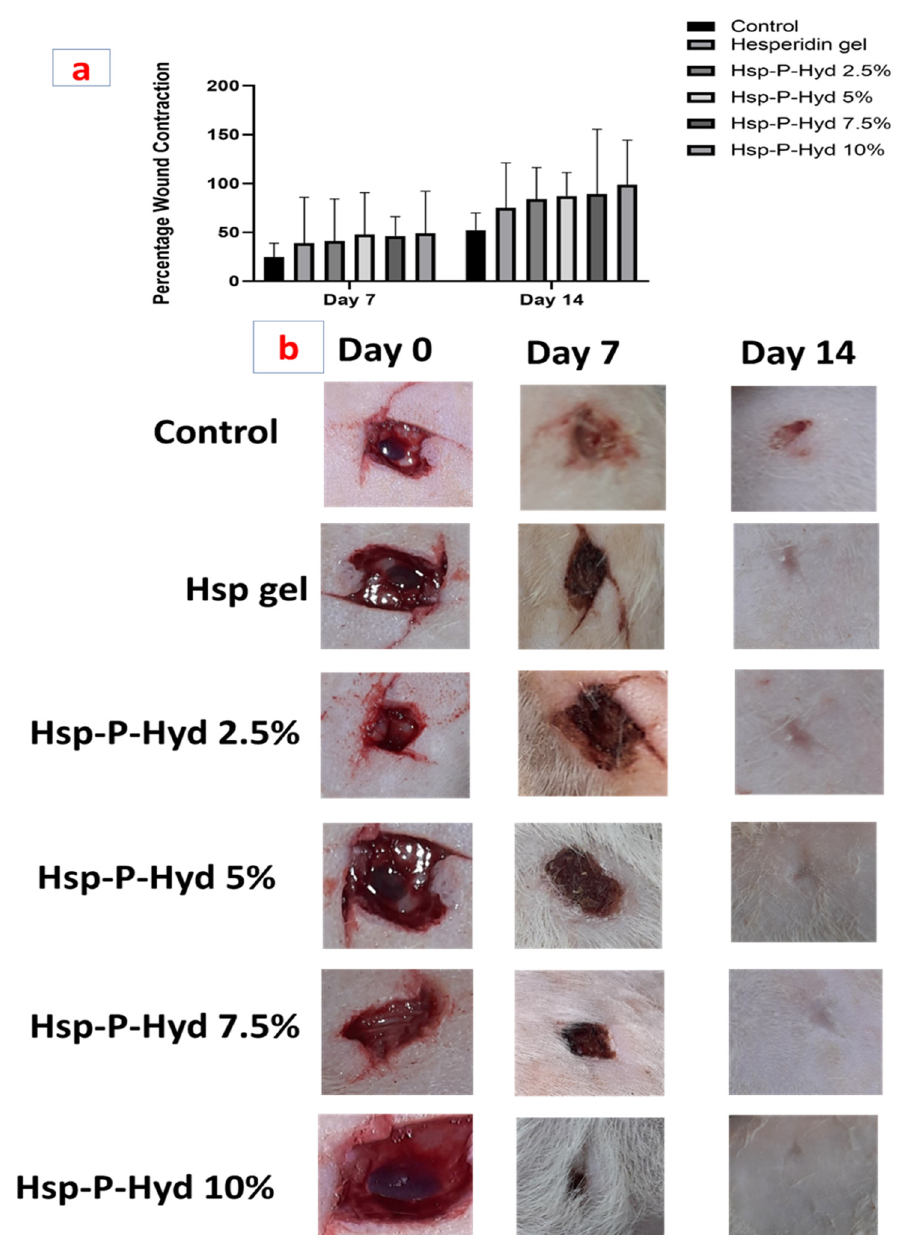
Figure 8. ( a ) Representation of percentage of wound contraction at 7 and 14 days ( b ) Representation of wound healing progression from 0 day to 14 day.